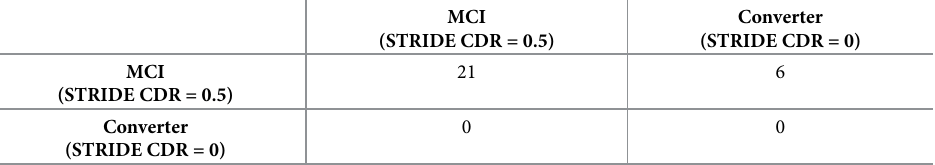
Table 4. Presurgical AD detection using AD-driven MCI biomarkers and Random Forest (RF) analysis.